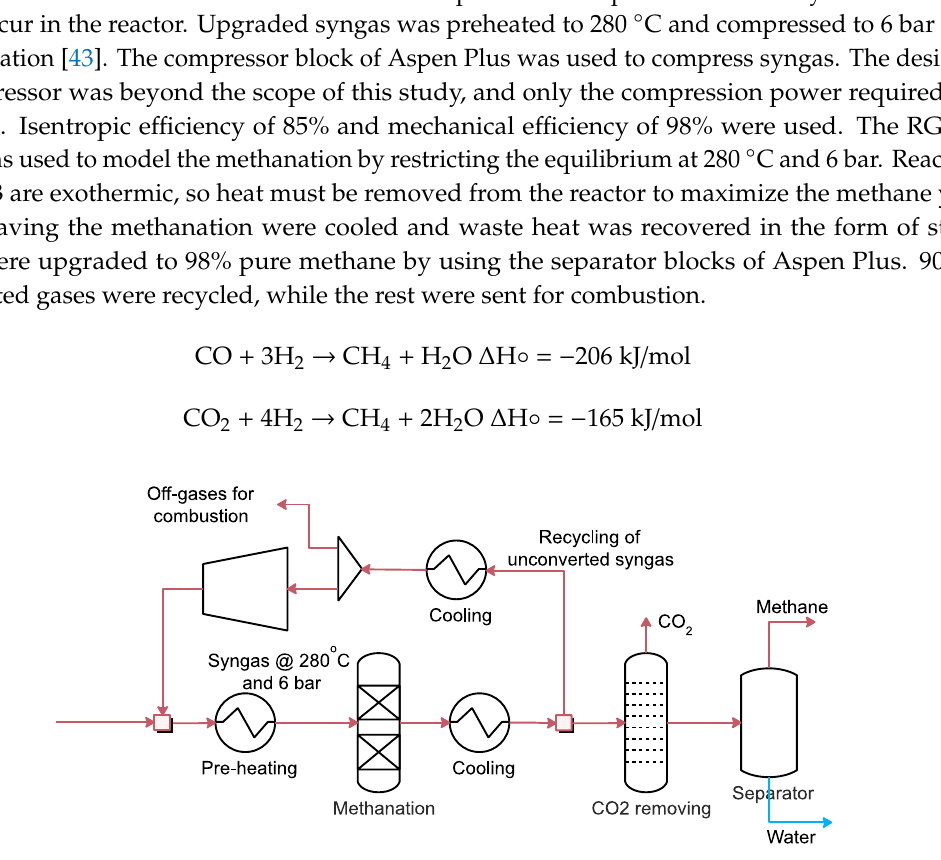
Figure 5. Process flow diagram of methane synthesis from syngas produced from waste gasification.